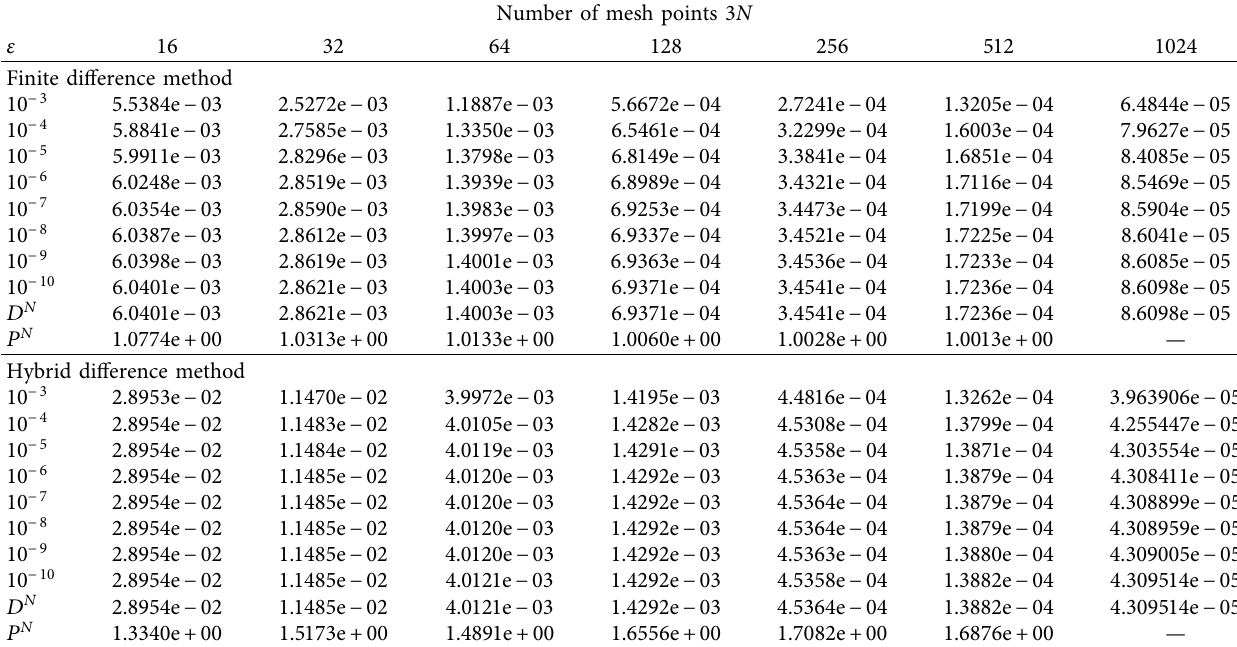
Table 2: Computed P N rate of convergence and D N maximum errors for Example